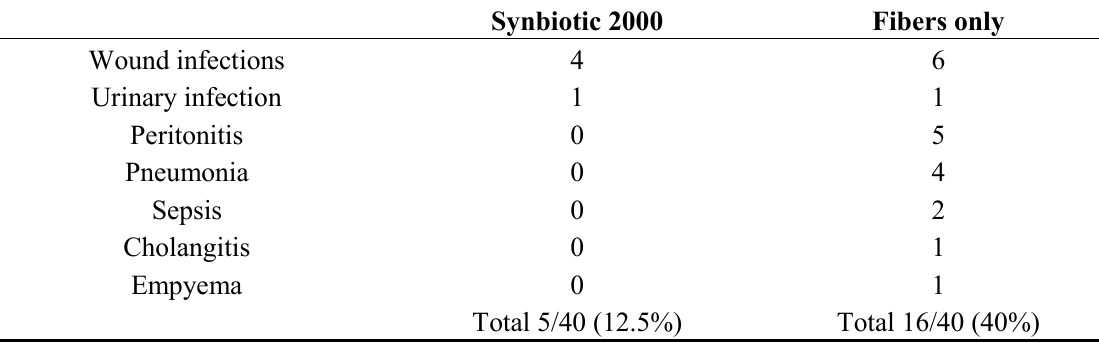
Table 5. Infective complications in patients undergoing pancreatoduodenectomy [98]; p < 0.05.